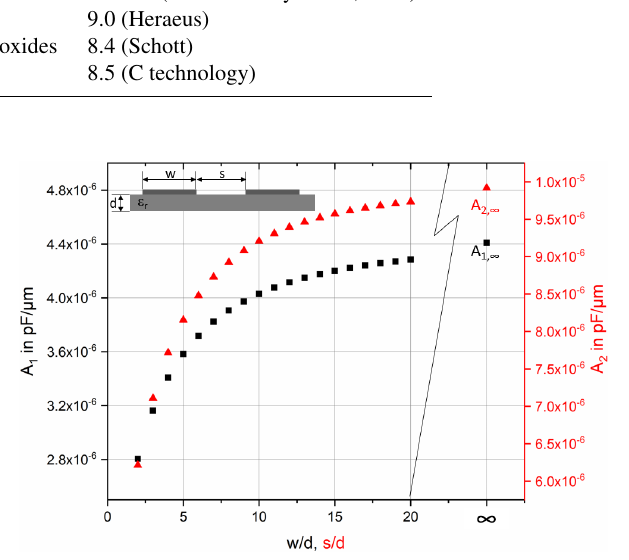
Figure 2. Progression of the geometry factors A 1 and A 2 for Eq. (1), adapted according to Alley and Bahl (Alley, 1970; Bahl,